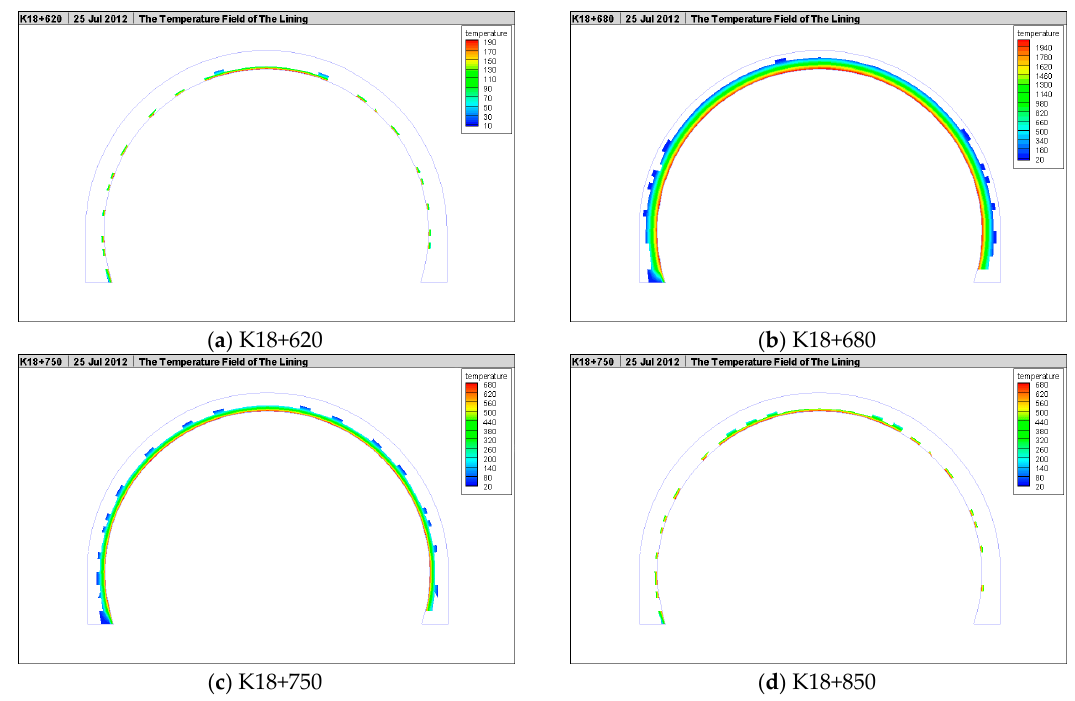
Figure 14. Cross section temperature in the tunnel lining.